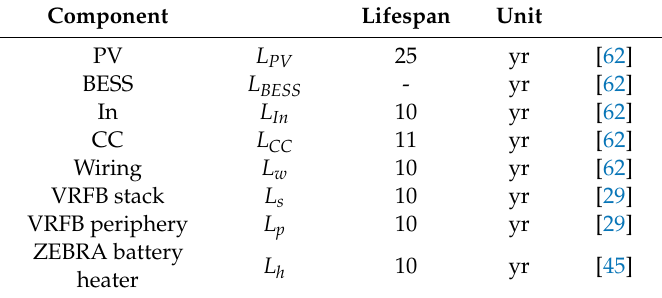
Table 6. Expected lifespan of the components.